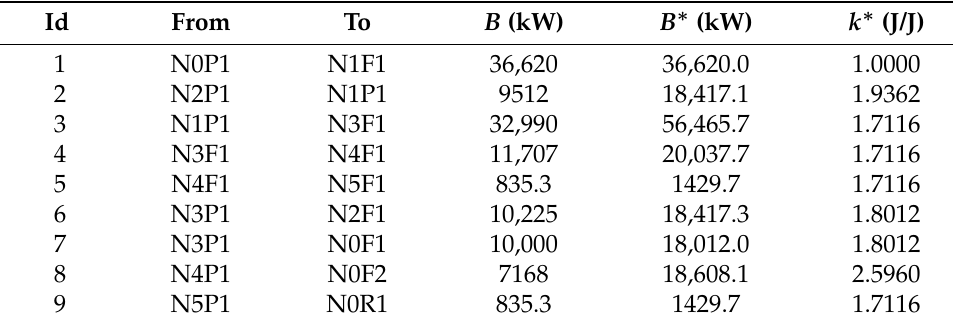
Table 5. Exergy cost of flows for TGAS